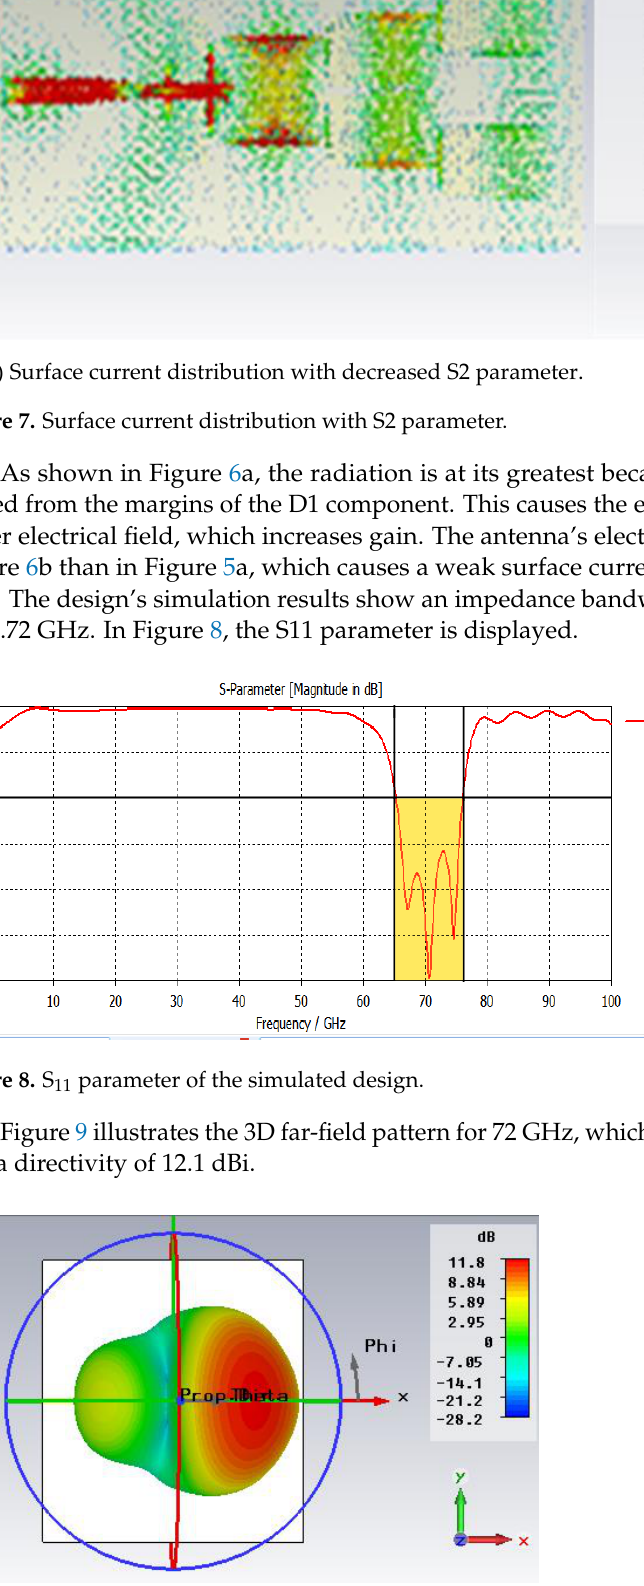
Figure 9. Radiation pattern of far field at 72 GHz.